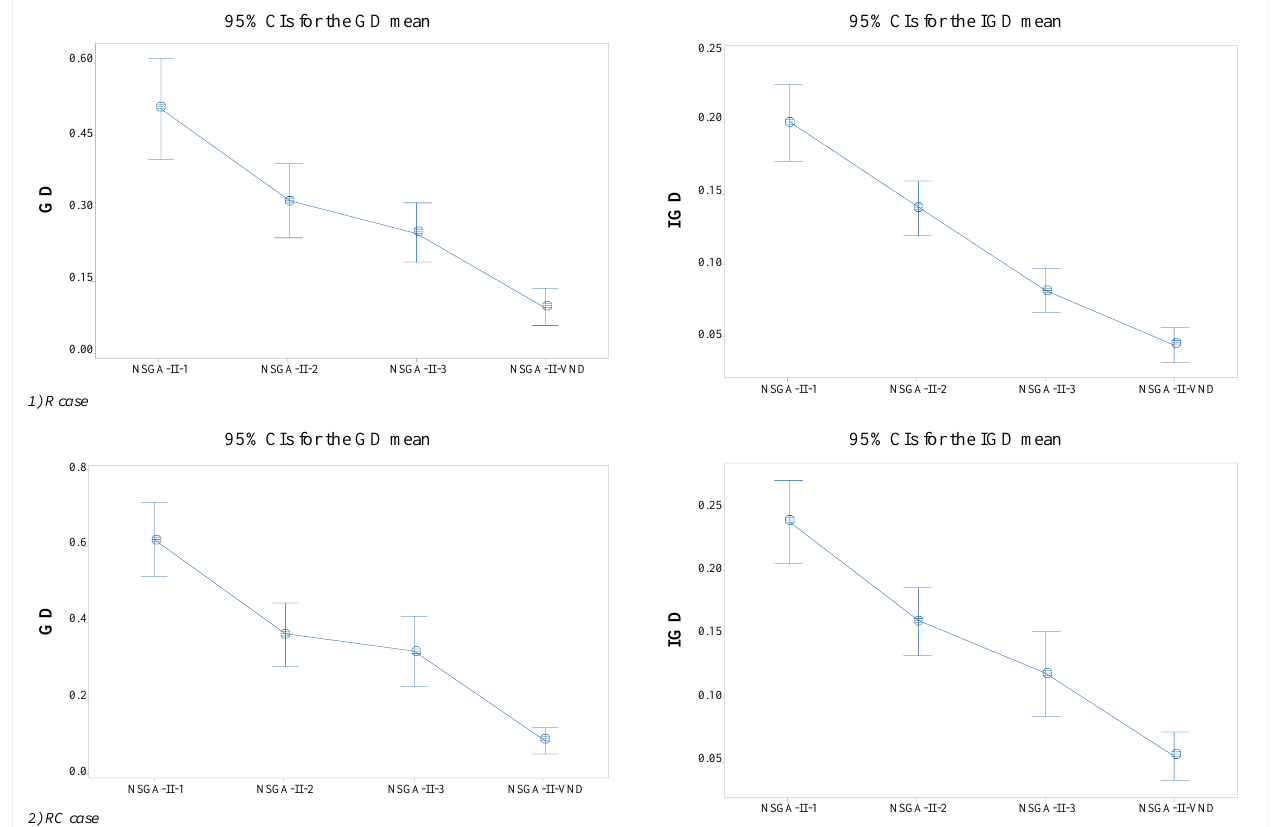
Figure 8. The comparison interval diagram of multiple strategies.